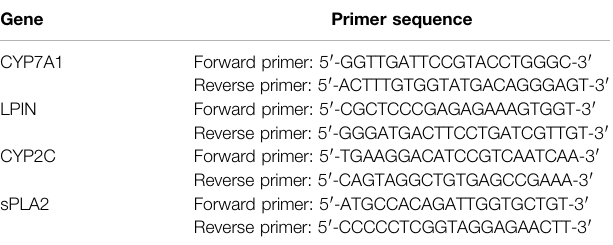
TABLE 1 | The primer sequences of real-time PCR. Gene Primer sequence